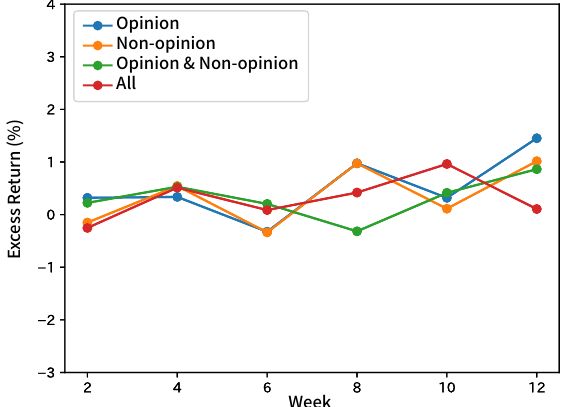
Figure 5. Excess returns of Broker B in forecasting analyst net income estimates.